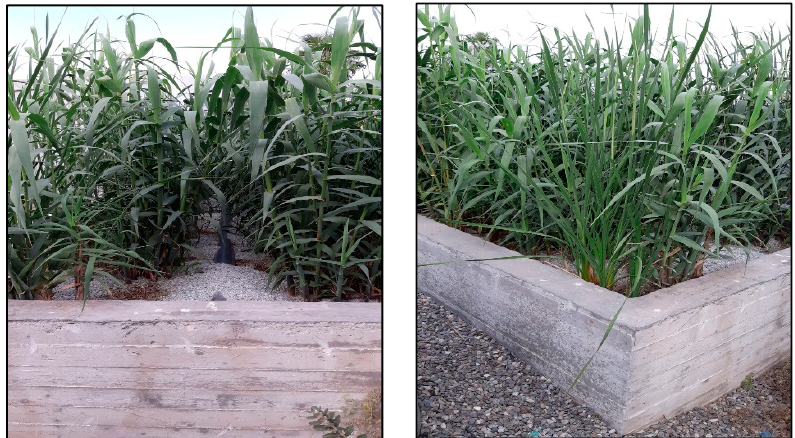
Figure 1. An overview of the vertical subsurface flow system (VSSFs) constructed wetland (CW) at ExpA_1.